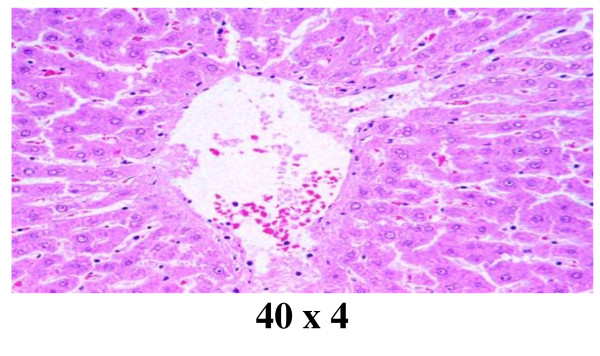
GNPs-treated rat received 100 μl of 20 nm particles for 3 days